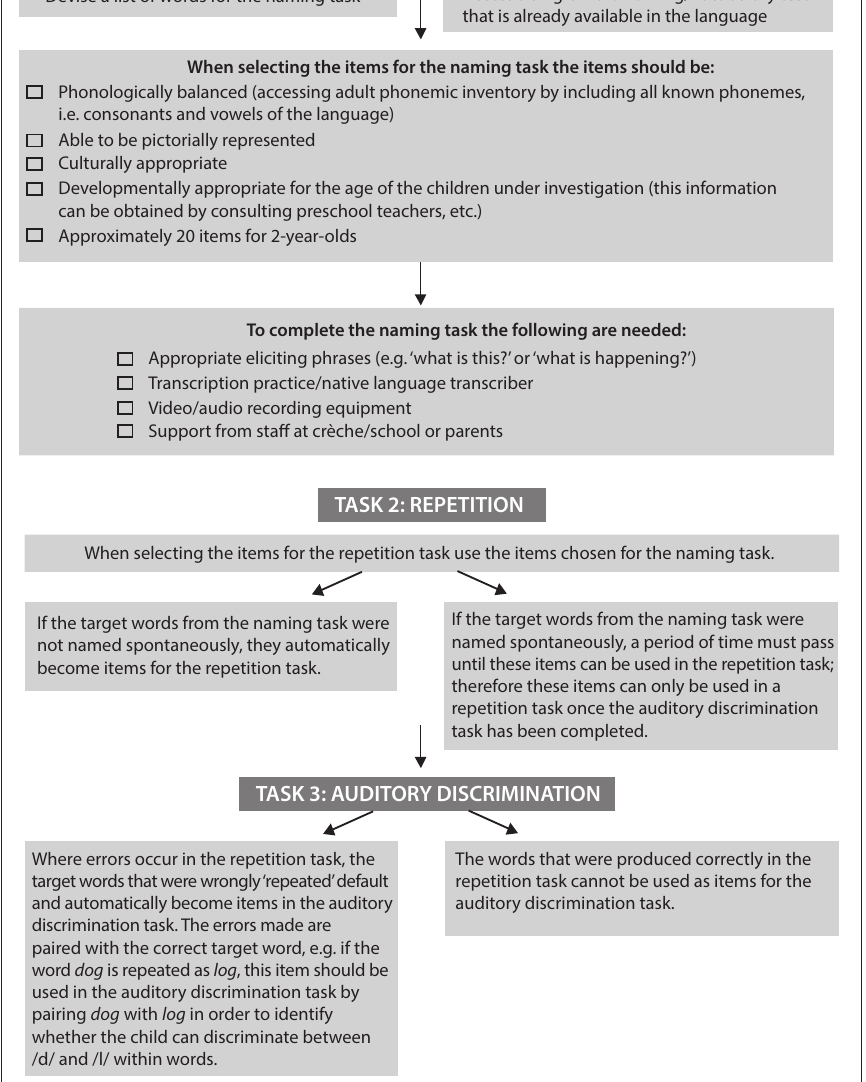
Fig. 1. A protocol for assessing speech processing and production in young children (from Fish et al.,